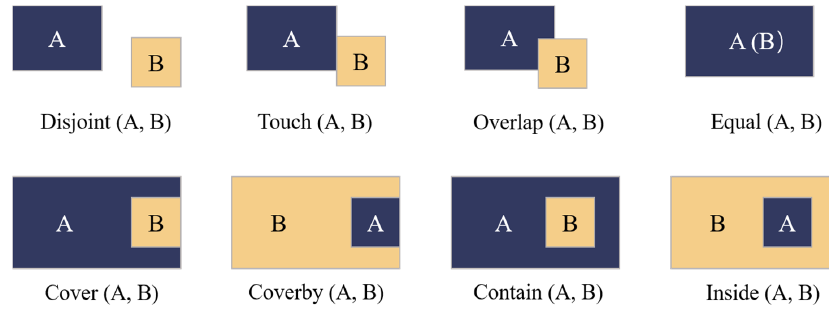
Figure 2. Eight spatial relations in GIS topology theory.